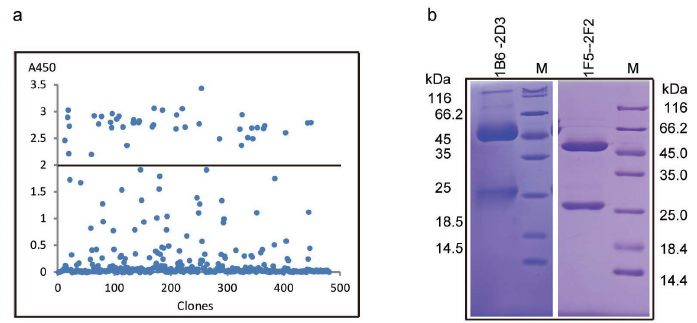
Figure 2. Preparation of the anti-PAT/pat mAbs. ( a ) Hybridoma screening. ( b ) the purified PAT/pat mAbs 1F5-2F2 and 1B6-2D3. Table 1. PAT/pat mAbs for ELISA method establishment.